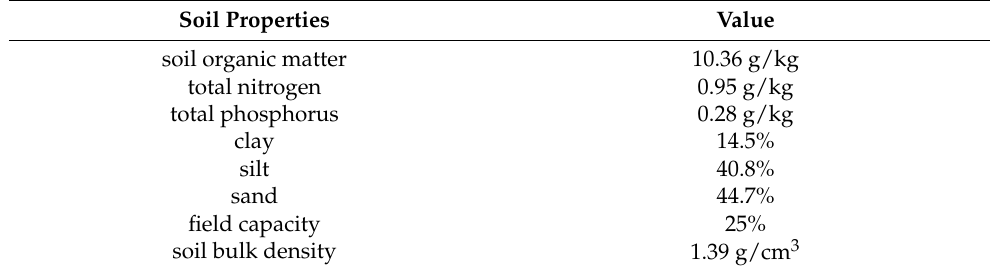
Table 1. Soil properties in the experimental field.